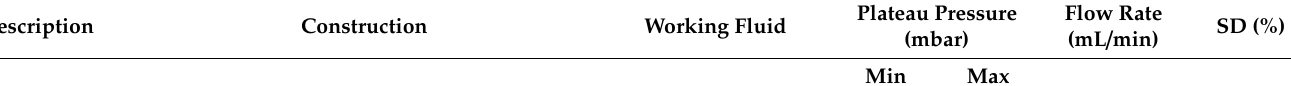
Table A1. Passive constant flow